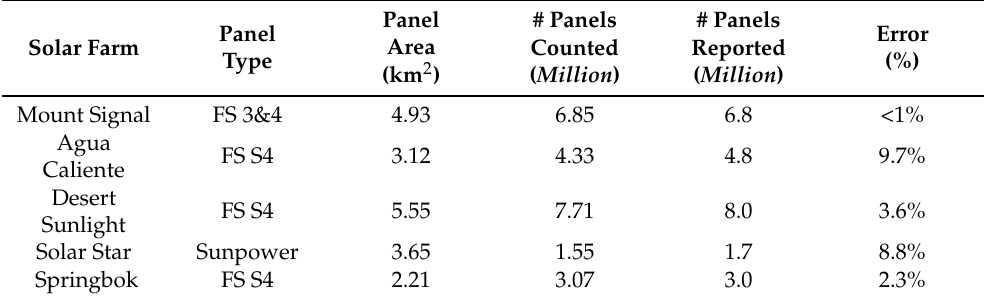
Table 4. Estimate of the number of panels. The panel area is converted into panel count, taking into account the type of panels in the farm and their corresponding